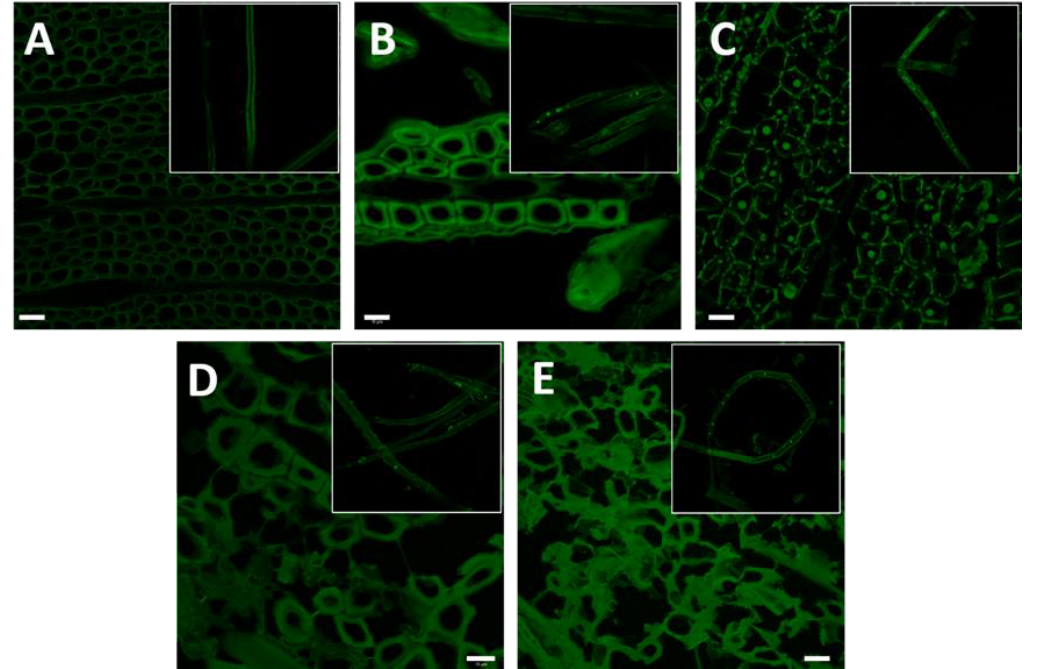
Figure 4. Laser-scanning confocal fluorescence microscopy (LSCM) image of pre-treated materials obtained by steam explosion at different severity factors. ( A ) S 0 = 8.53; ( B ) S 0 = 9.11; ( C ) S 0 = 10.42; ( D ) S 0 = 11.63; ( E ) S 0 = 12.31. Bar size: 10 µm. In the insert, the distribution of lignin along the fibre can be observed.